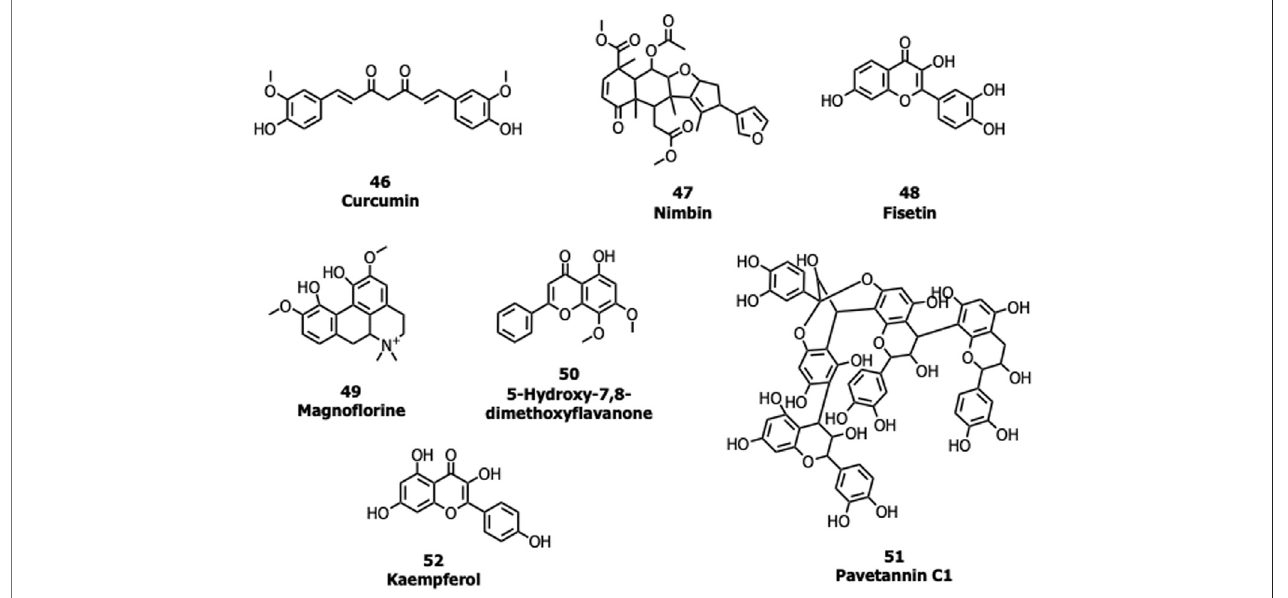
FIGURE 11 | Natural products targeting the S